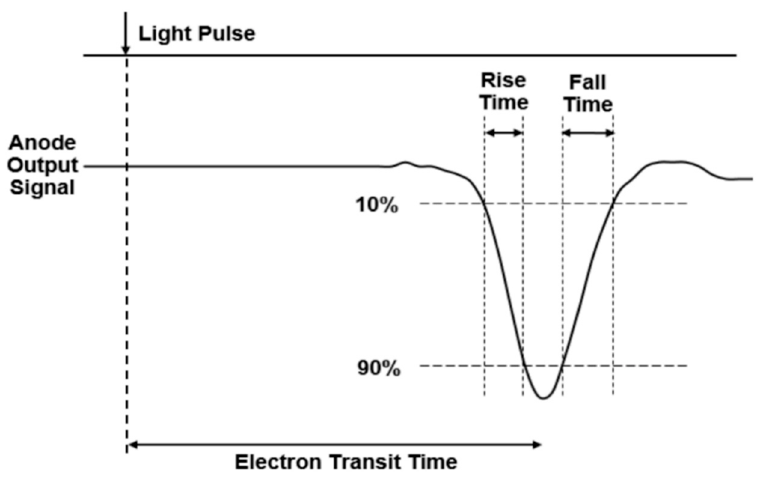
Figure 6. Definition of time characteristics of a PMT.